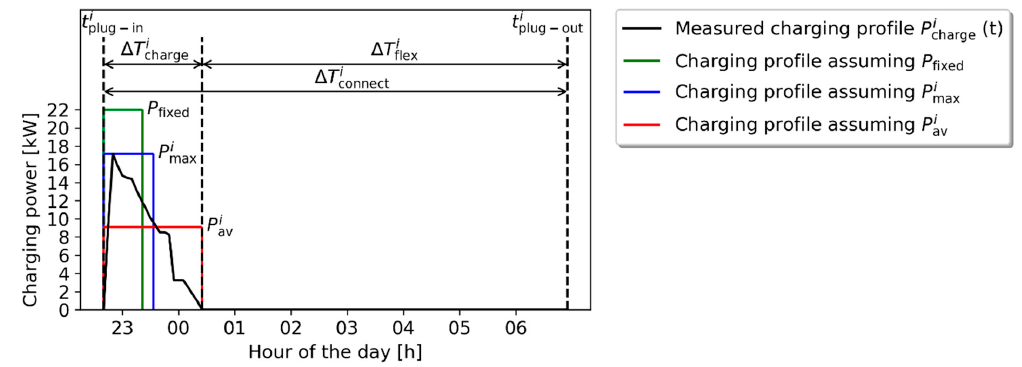
Figure 1. Example of measured and constant charging power profiles using a typical transaction i by a battery electric vehicle (BEV). The measured charging power profile of this example transaction i , which is 𝑃 (cid:2913)(cid:2918)(cid:2911)(cid:2928)(cid:2917)(cid:2915)(cid:3036) (𝑡) [ kW ] , is shown in black. Like any realistic charging profile, this profile is not constant. The black arrows on top illustrate the definitions of Δ𝑇 (cid:2913)(cid:2925)(cid:2924)(cid:2924)(cid:2915)(cid:2913)(cid:2930)(cid:3036) , Δ𝑇 (cid:2913)(cid:2918)(cid:2911)(cid:2928)(cid:2917)(cid:2915)(cid:3036) , and Δ𝑇 (cid:2916)(cid:2922)(cid:2915)(cid:2934)(cid:3036) for the measured transaction i . Further, the three corresponding constant charging power profiles (green, blue, and red) are depicted for this transaction i , using three different constant charging powers: 𝑃 (cid:2916)(cid:2919)(cid:2934)(cid:2915)(cid:2914) , 𝑃 (cid:2923)(cid:2911)(cid:2934)(cid:3036) , and 𝑃 (cid:2911)(cid:2932)(cid:3036) . For all profiles, the energy charged during the transaction is kept equal to the measured value ( 𝐸 (cid:2928)(cid:2915)(cid:2927)(cid:3036) ).